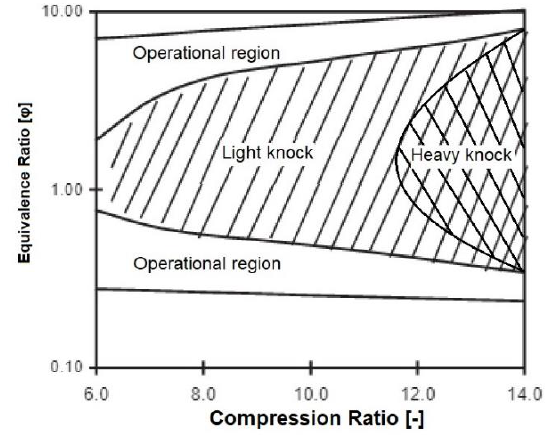
Fig. 1. Regions of hydrogen combustion in SI engines with the heavy knock distinction introduced by the author [11,